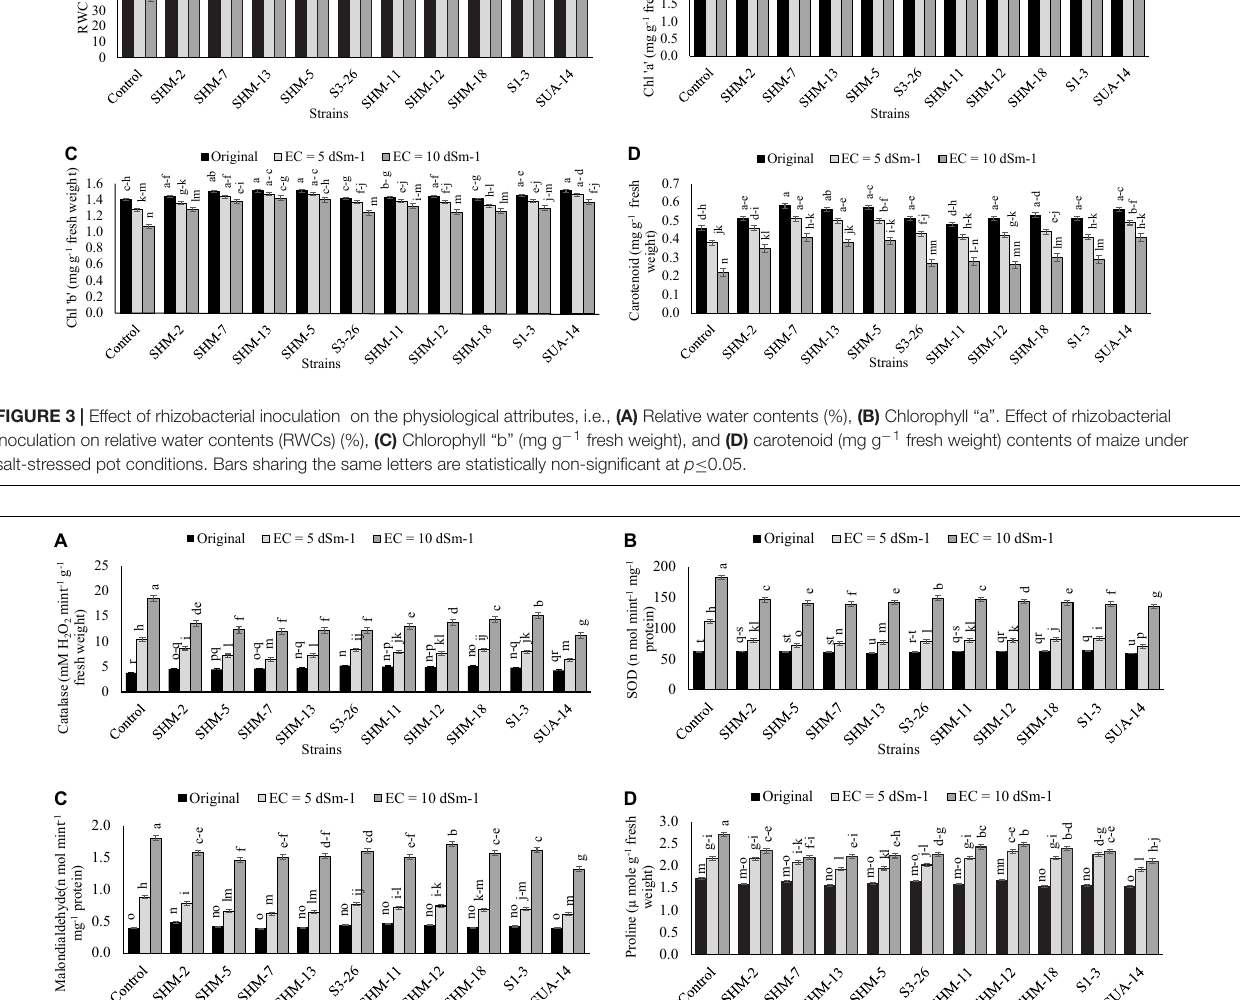
(92%), grain P contents (65%), leaves P contents (11%), and